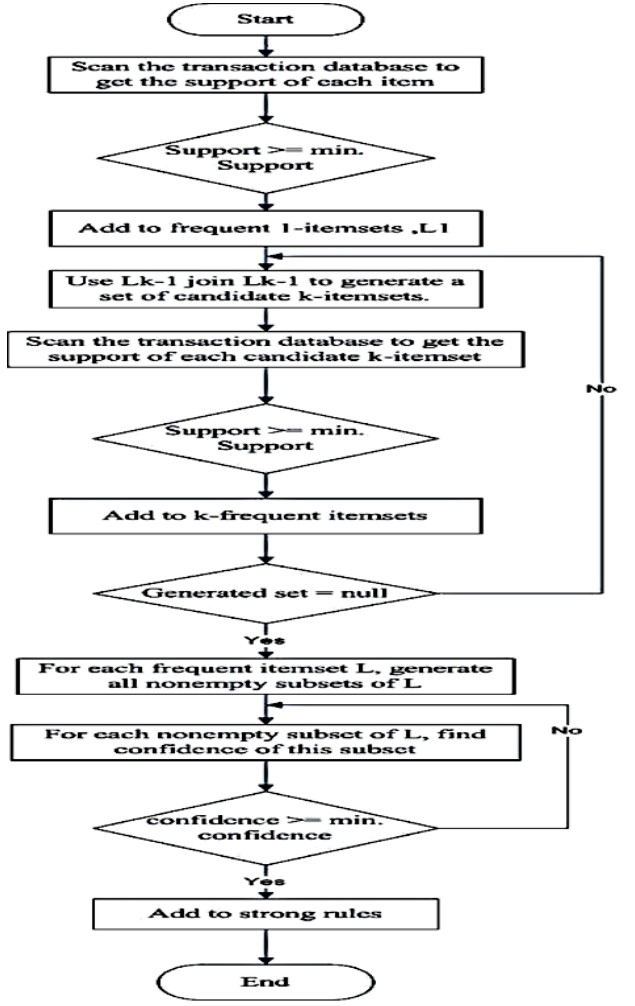
Figure 11. Generate an association rule flow